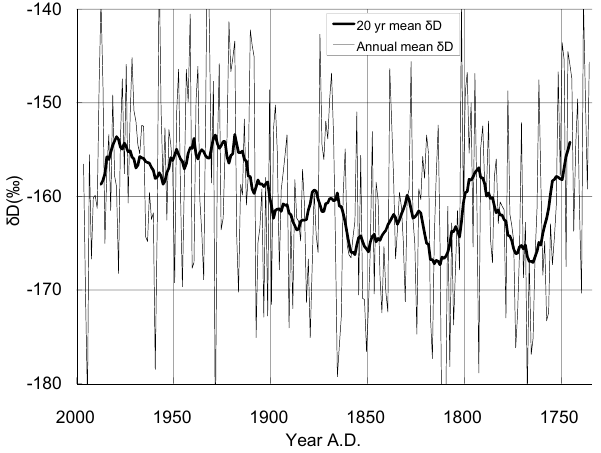
Fig. 4. Annual mean (thin line) and 20yr mean (thick line) δ D pro- files. Note that the average isotope ratio increases from the late 19th to the early 20th century.